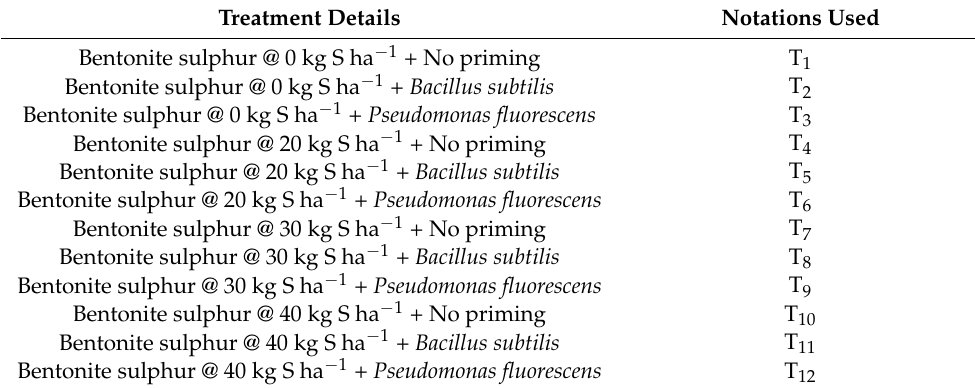
Table 2. Treatment details used in the